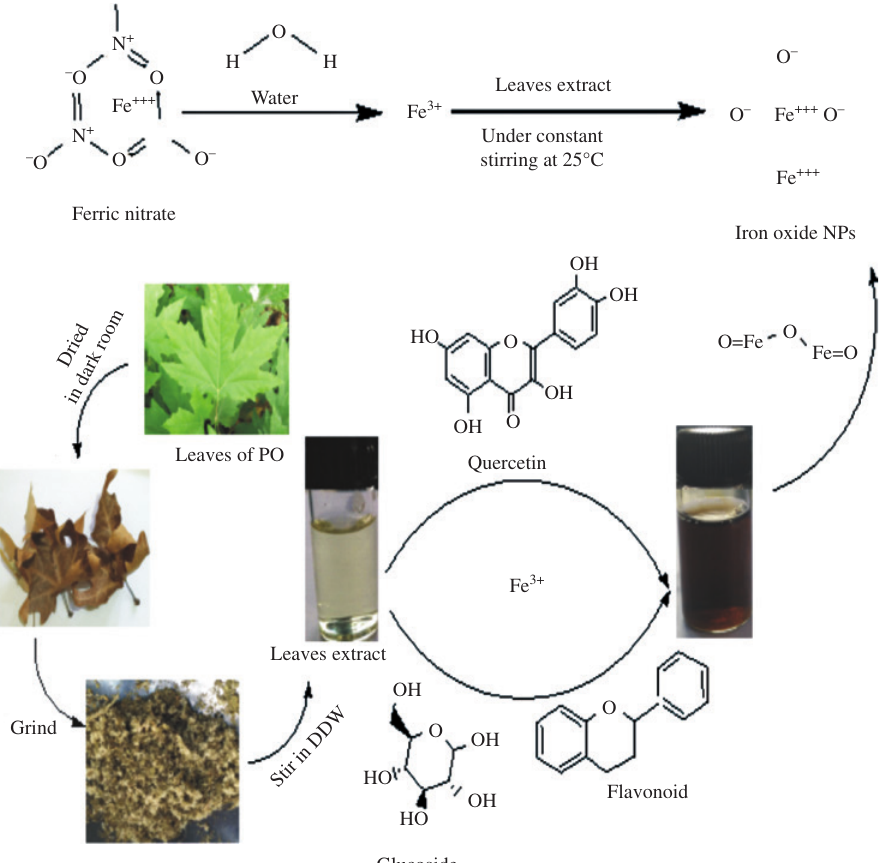
Figure 1: Mechanism involved in the synthesis of iron oxide nanoparticles using the leaf extract of Platanus orientalis